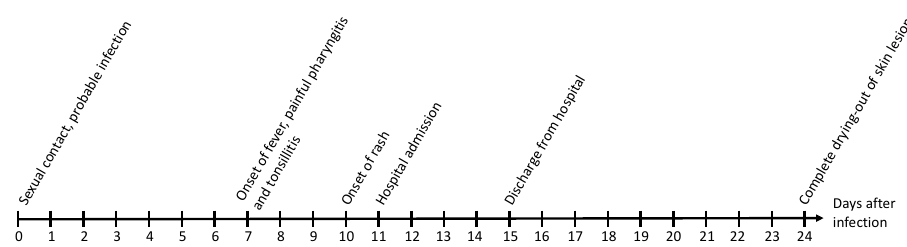
Figure 3. Time course of the monkeypox infection.